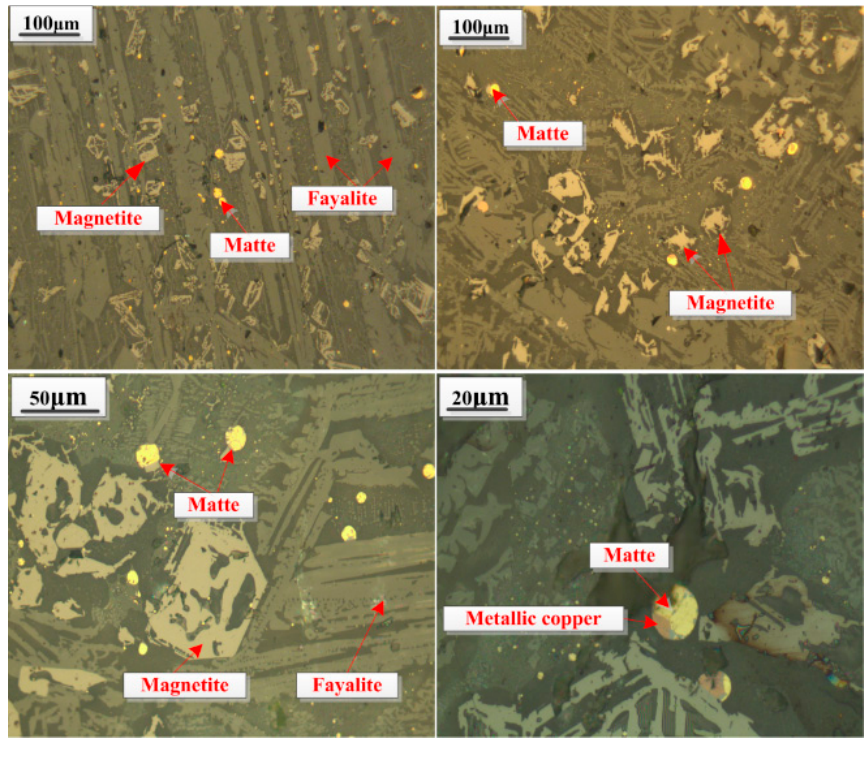
Figure 2. Microstructure of copper slag.